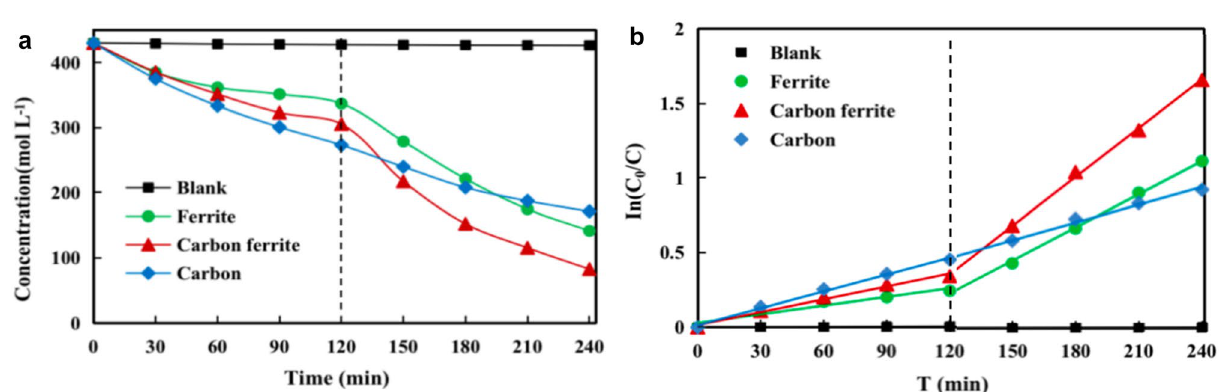
Figure 8. ( a ) Carbon ferrite adsorptivities (0–120 min) and photoactivities (121–240 min) for nitrogen compounds removal under visible light irradiation. ( b ) Plots of ln(C 0 /C) versus reaction time, showing the fitting results using the pseudo-first-order reaction.